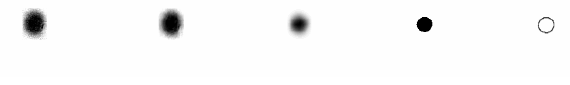
Figure 7. Images of a glass ball for calibration ( D = 2 mm).